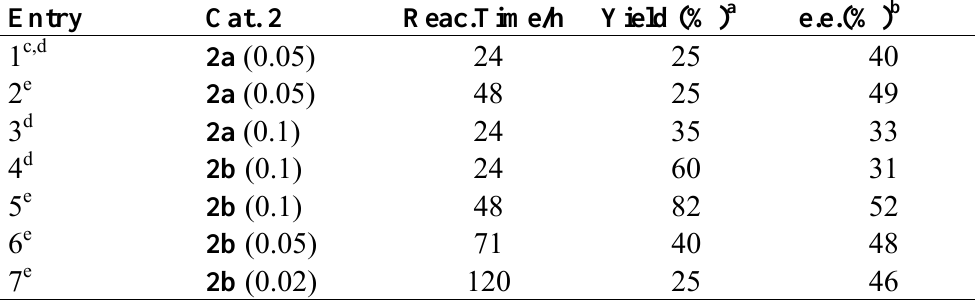
Table 1. Asymmetric organocatalytic F.C. alkylation of indole 3 with chalcone 4a